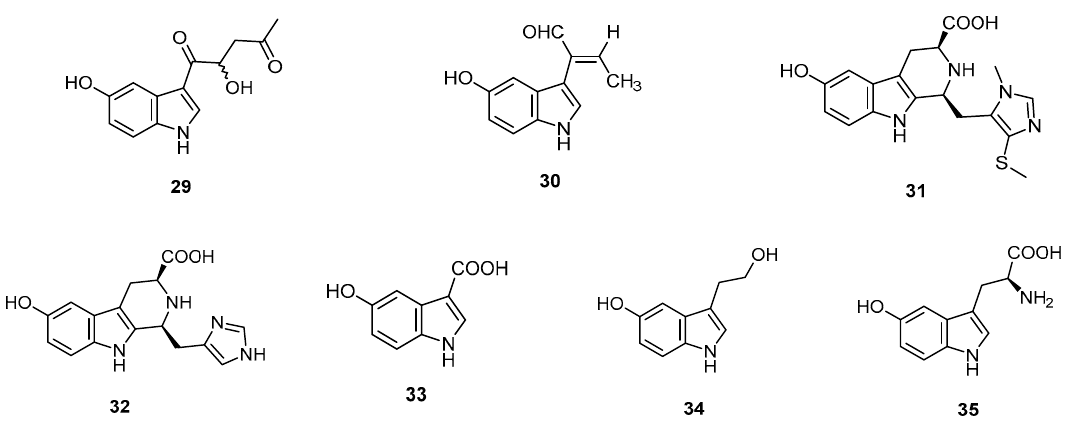
Figure 9. Chemical structures of hainanerectamine A ( 29 ), hainanerectamine B ( 30 ), hainanerectamine C ( 31 ) and the alkaloids 32 – 35 .